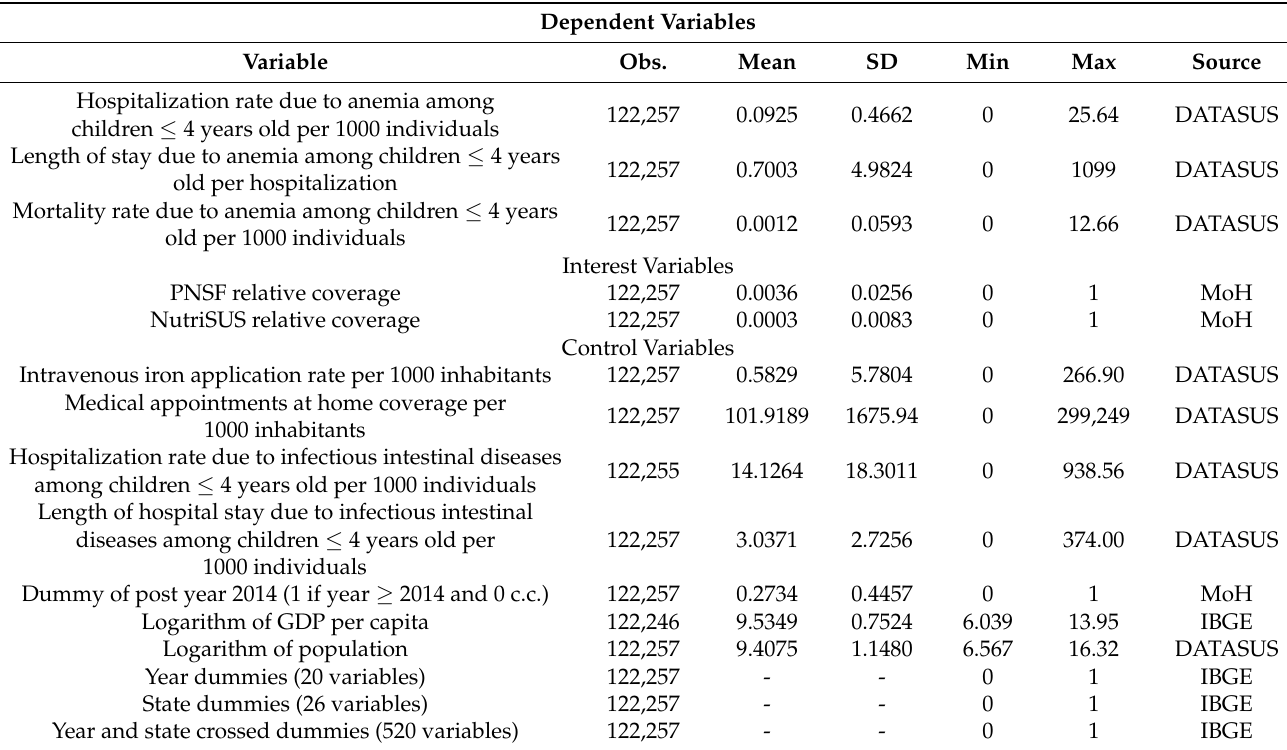
Table 1. Description of the variables of the